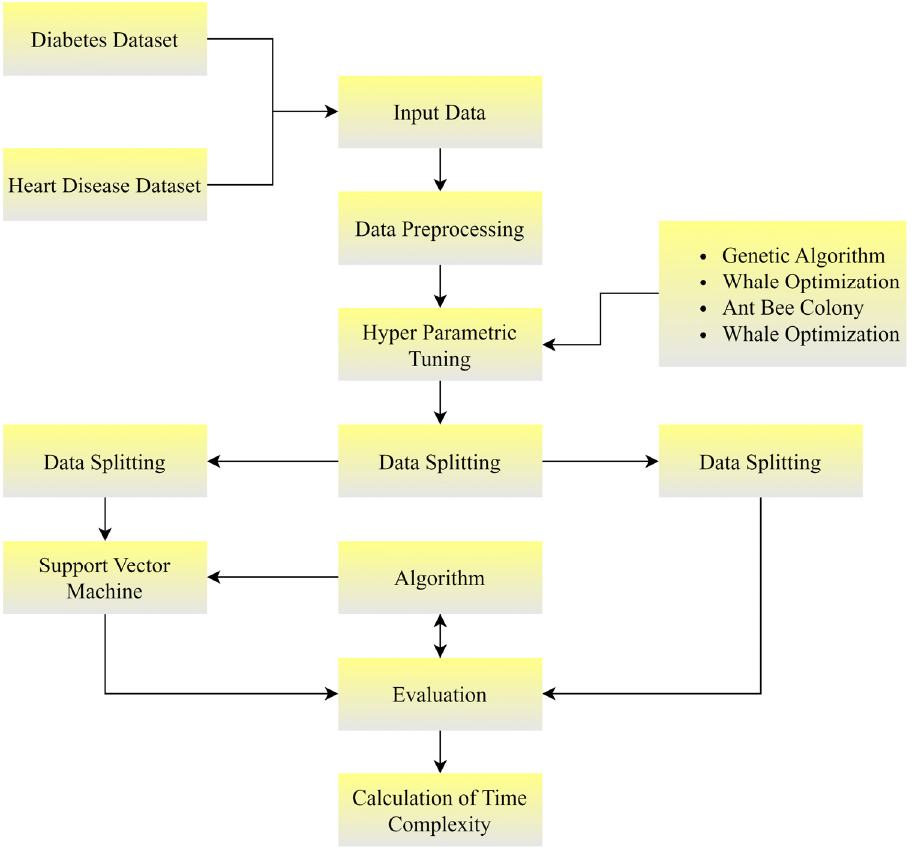
Figure 1. Proposed flow dataset description.